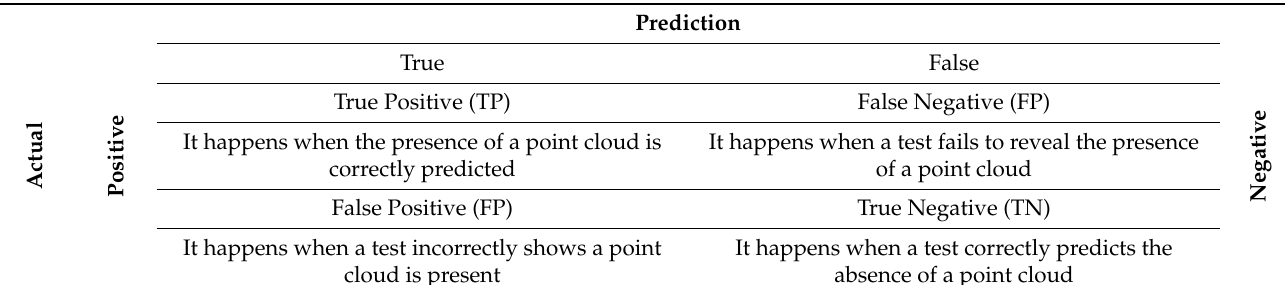
Table 1. Confusion